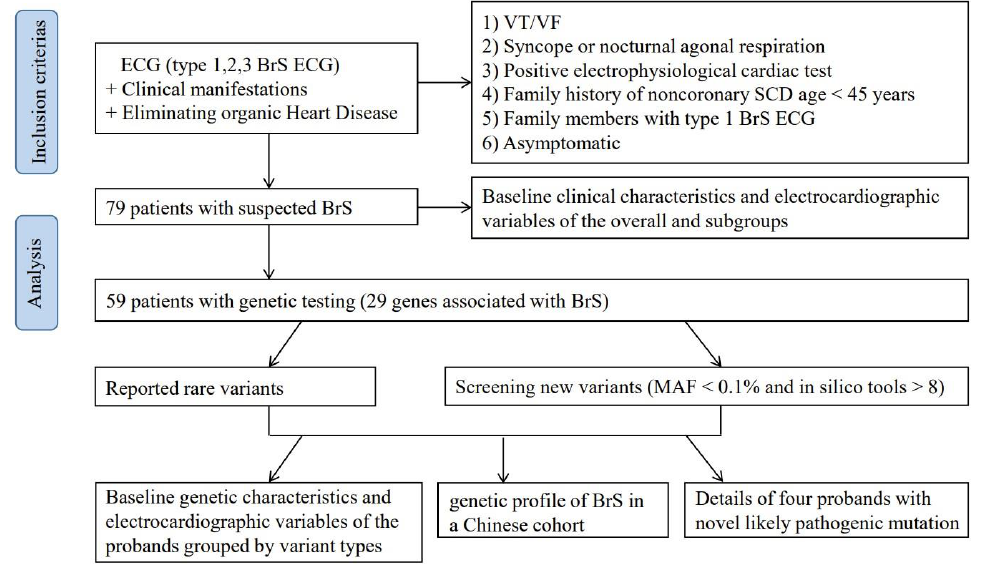
Figure 1. Flowchart of data collection and research process. BrS = Brugada syndrome; ECG = electrocardiogram; VT = ventricular tachycardia; VF = ventricular fibrillation; SCD = sudden cardiac death; and MAF = minor allele frequency. Table 2. Clinical and genetic characteristics of SCN5A variant carriers.